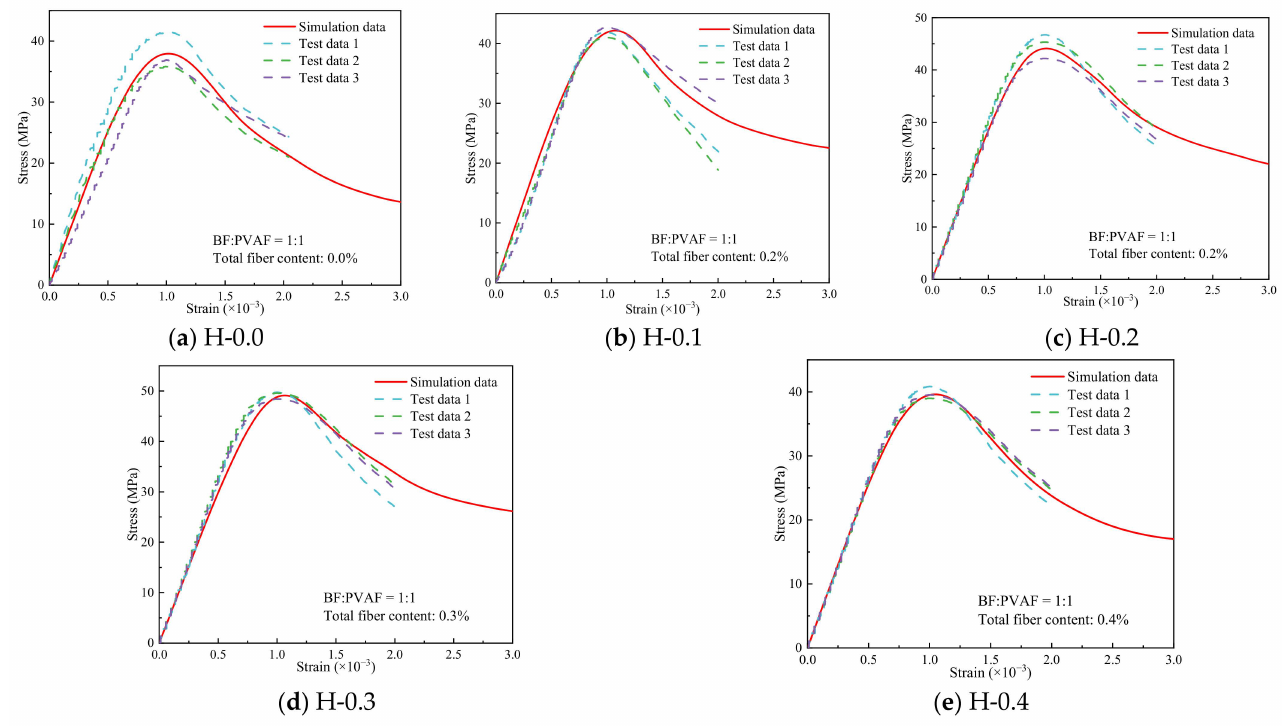
Figure 26. Comparison of compressive stress-strain curves of hybrid fiber-reinforced LHPCC (test and simulation curves).